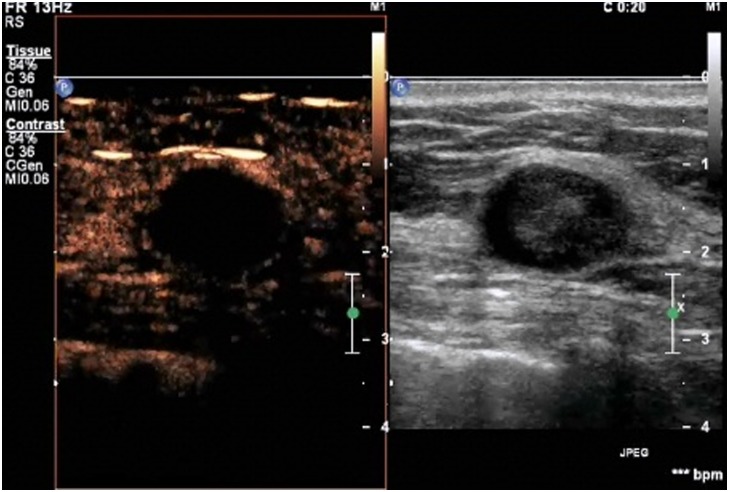
A lesion with a score of 1 by breast contrast-enhanced ultrasound.There is no enhancement in the lesion, with a clear borderline separating the lesion from the surrounding tissue.